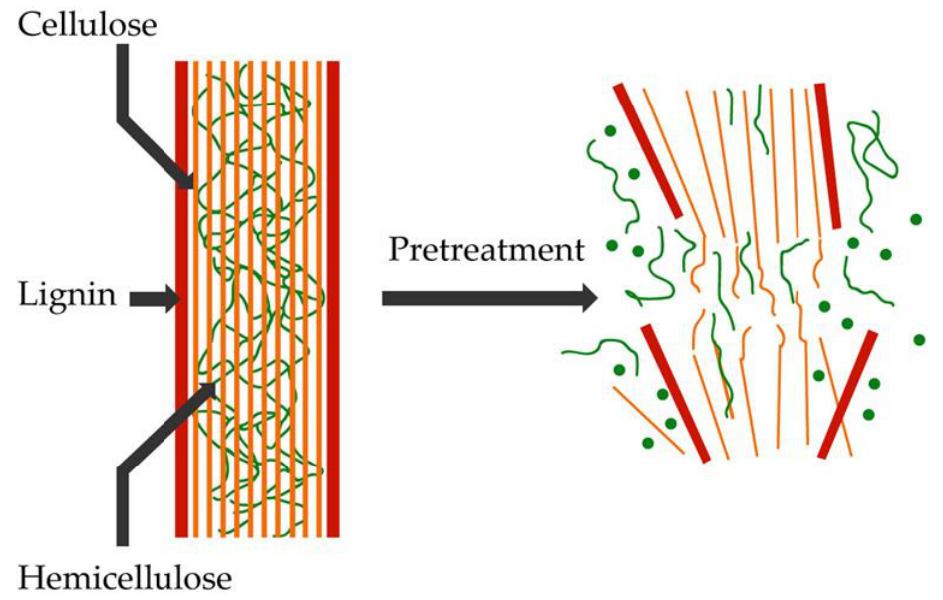
Figure 3. Degradation of lignocellulosic biomass into cellulose, hemicellulose, and lignin via pretreatment [23].